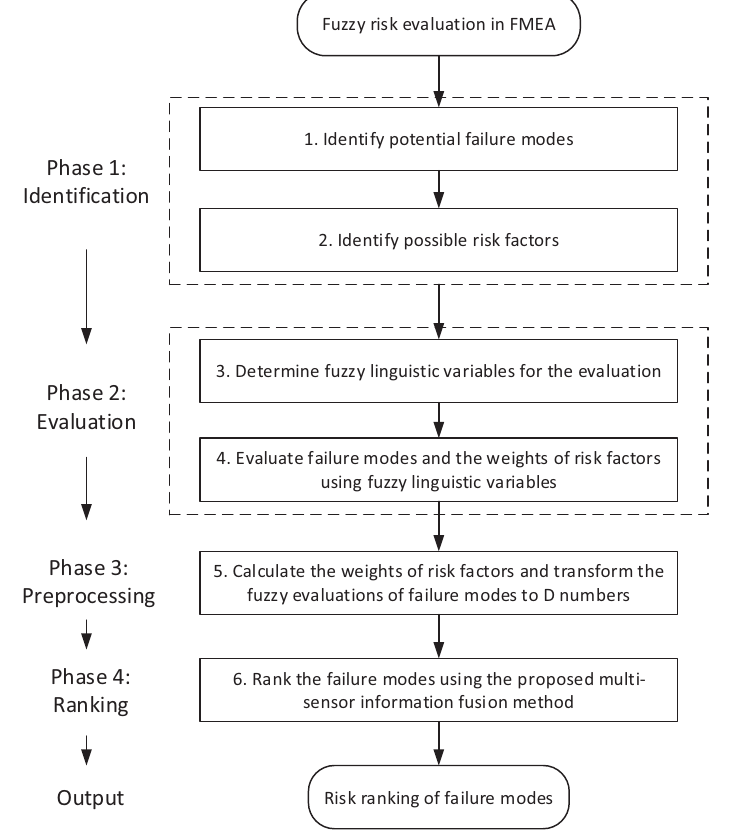
Figure 3. Flowchart of the proposed model for fuzzy risk evaluation in